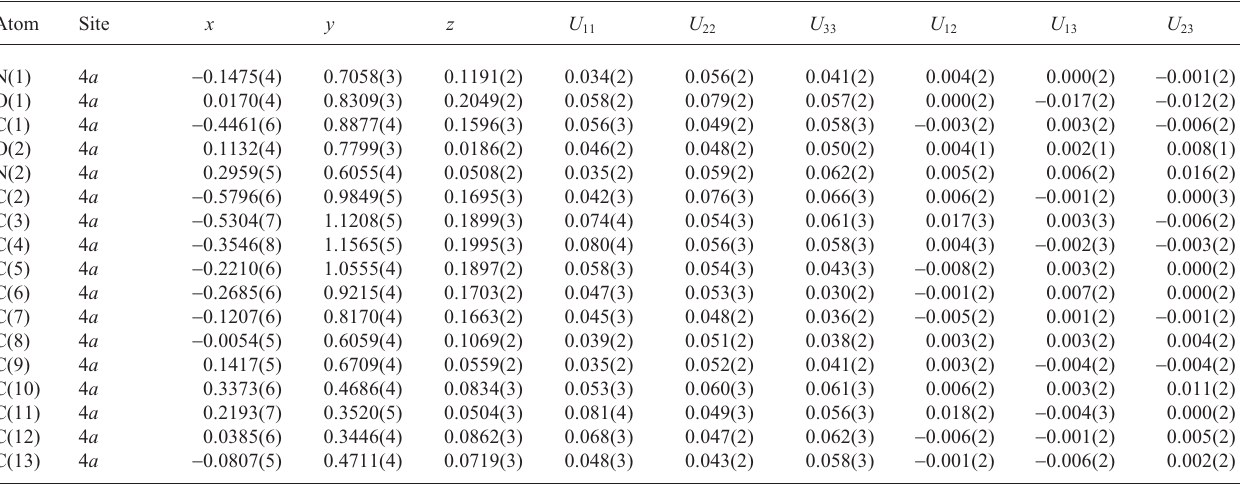
Table 3. Atomic coordinates and displacement parameters (in Å 2 )